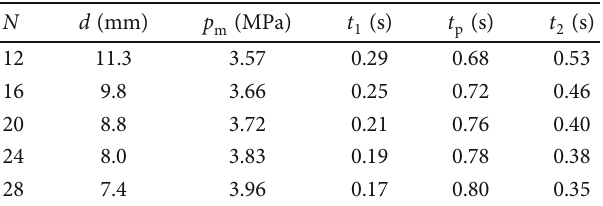
Figure 10: The pressure evolutions in the combustor for di ff erent transport pipeline structures. Table 5: Calculated results of internal ballistic characteristics for di ff erent structures of transport